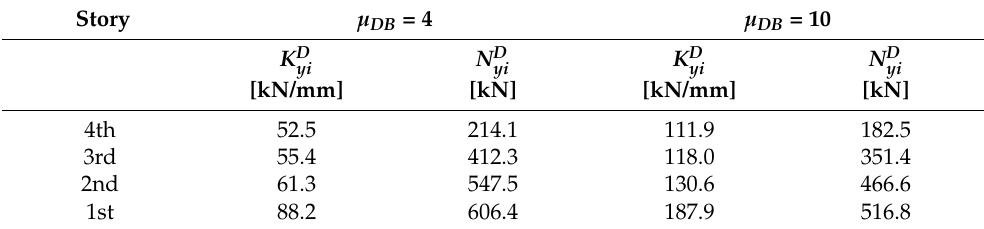
Table 5. Four-story MRF: elastic stiffness 𝐾 (cid:3052)(cid:3036)(cid:3005) and yield force 𝑁 (cid:3052)(cid:3036)(cid:3005) of the dampers at each story in X-direction for µ DB = 4 and µ DB = 10.